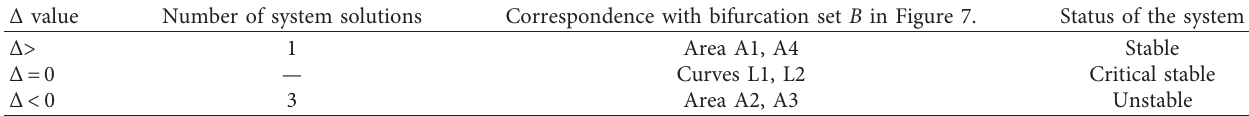
Table 3: Relationship between system solution and system state.